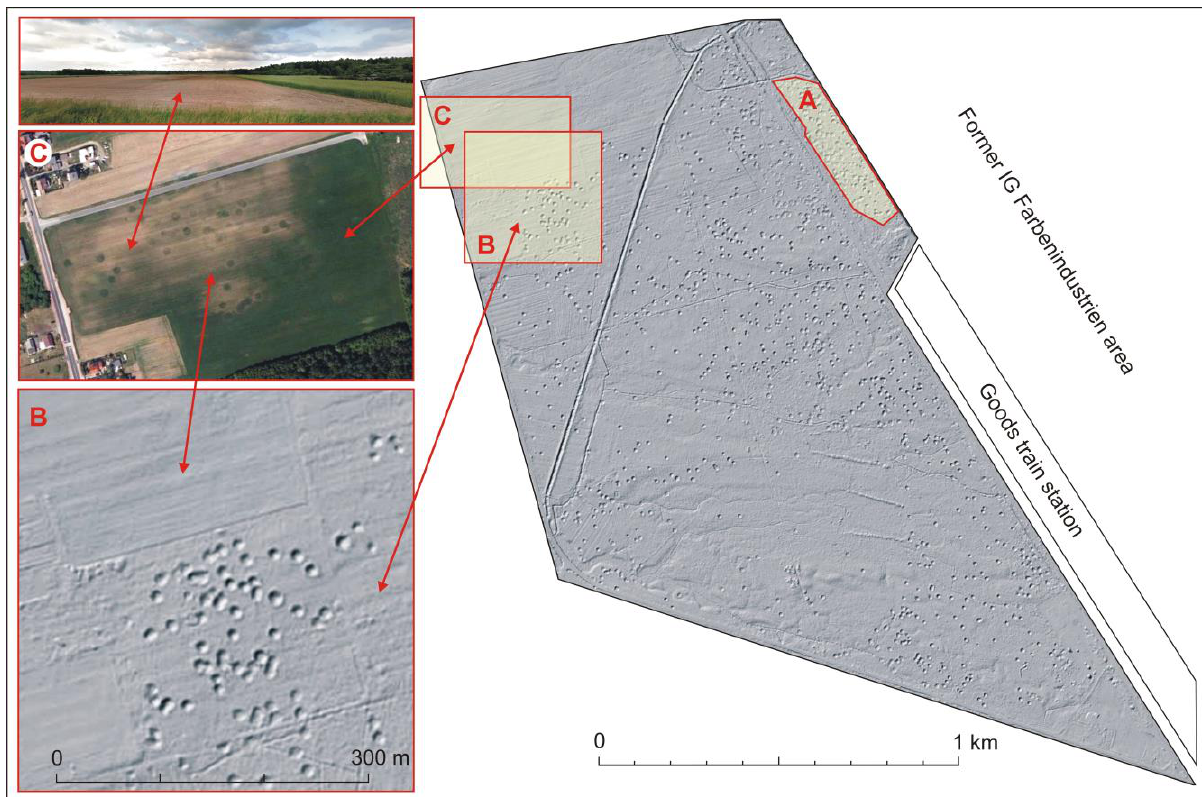
Fig. 4. Contemporary shaded terrain models and orthophotomap of one of the bombed areas in Kędzierzyn-Koźle (prepared by J.M. Waga, maps available from polska.e-mapa.net). A – area with the highest density of craters up to 77 per ha, B – concentration of craters, C – outlines of backfilled craters highlighted by varying